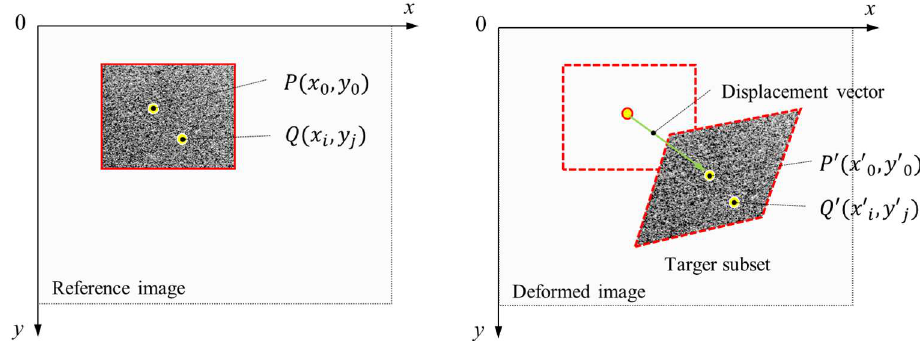
Figure 1. Schematic showing the correlation of the images of a reference subset before deformation and the target (or deformed) subset after deformation.